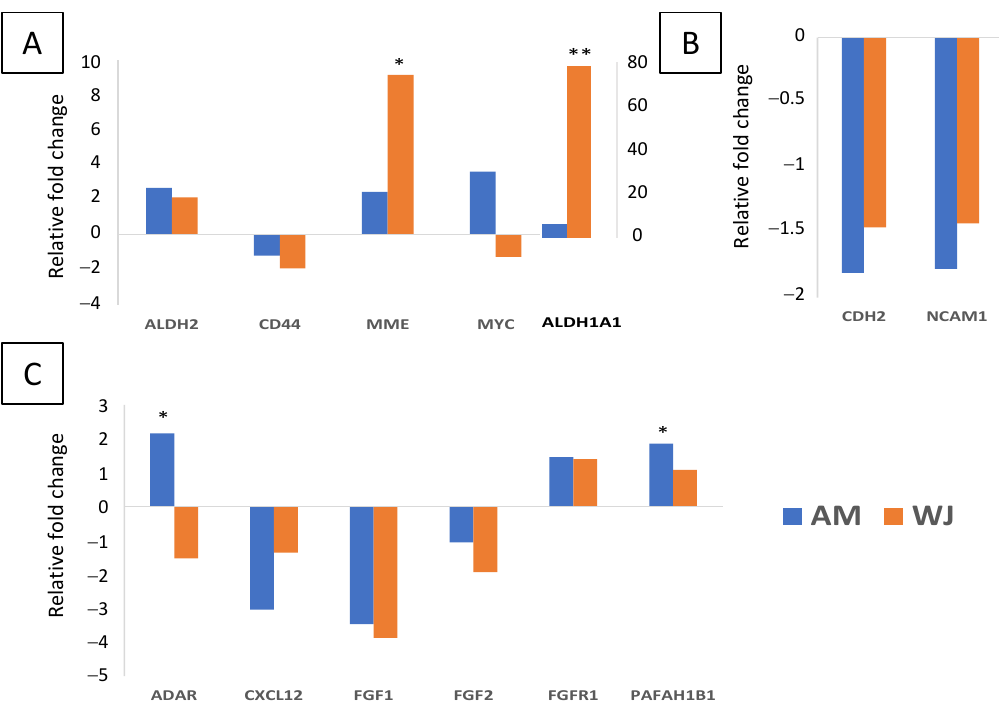
Figure 5. Differential expression of genes associated with self-renewal and stemness in AM- and WJ-MSCs during osteogenesis. ( A ) Stemness, ( B ) cell adhesion and ( C ) self-renewal genes. The y-axis on the right side in ( A ) indicates the expression level of ALDH1A1 only. Asterisks (*) and (**) represent statistical significance of p < 0.05 and p < 0.005,